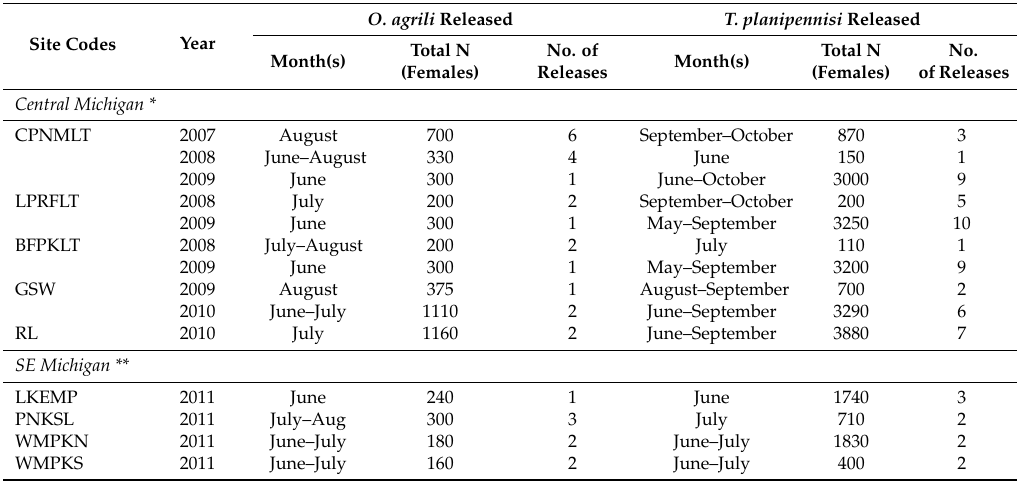
Table A2. Summary of adult O. agrili and T. planipennisi females released at the study release plots in central and southeastern